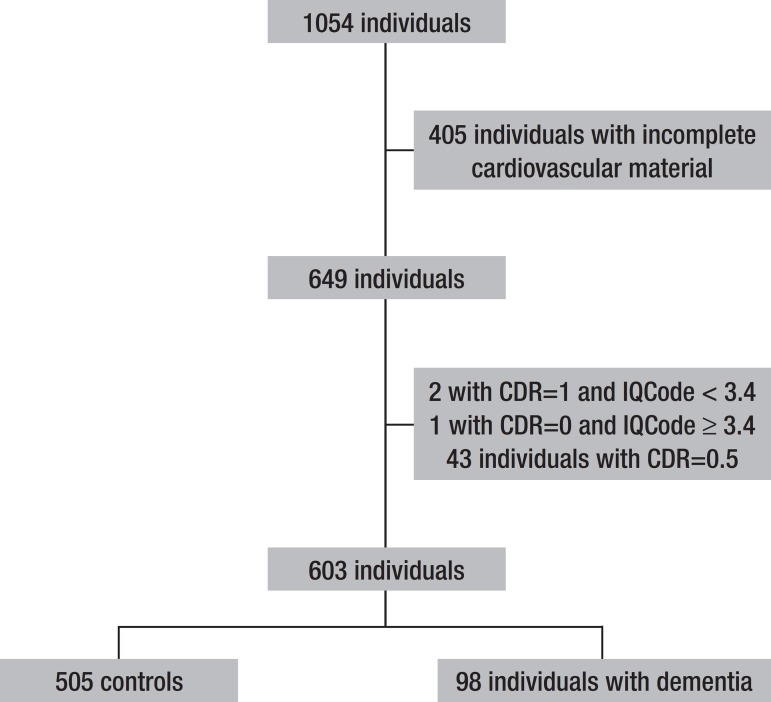
Flow diagram of the participants of the study.